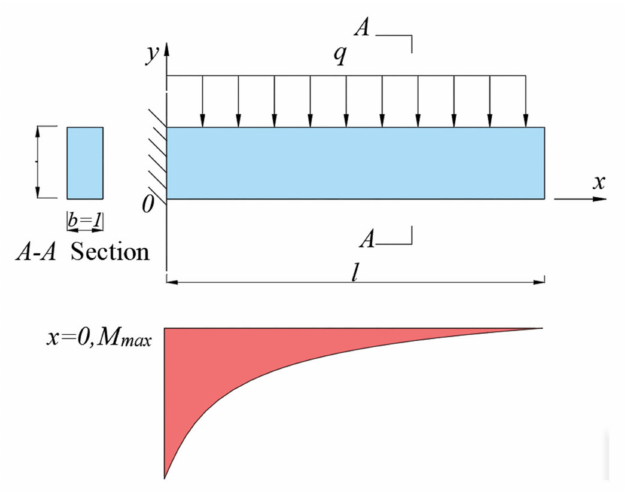
Figure 6. Force model and bending moment diagram of a cantilever